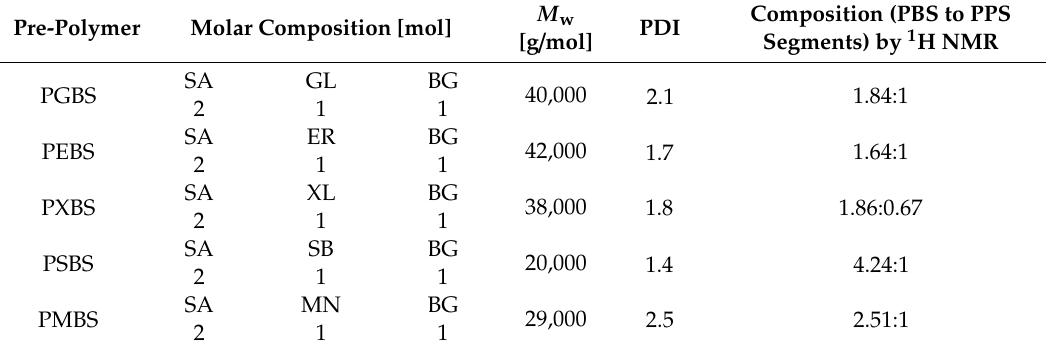
where M w : weight average molecular weight, PDI: polydispersity index, SA: sebacic acid, BG: butylene glycol, XL: xylitol, SB: sorbitol, ER: erythrytol, GL: glycerol, Mn: mannitol, PBS: poly(butylene sebacate) segment, PPS: poly(polyol sebacate)